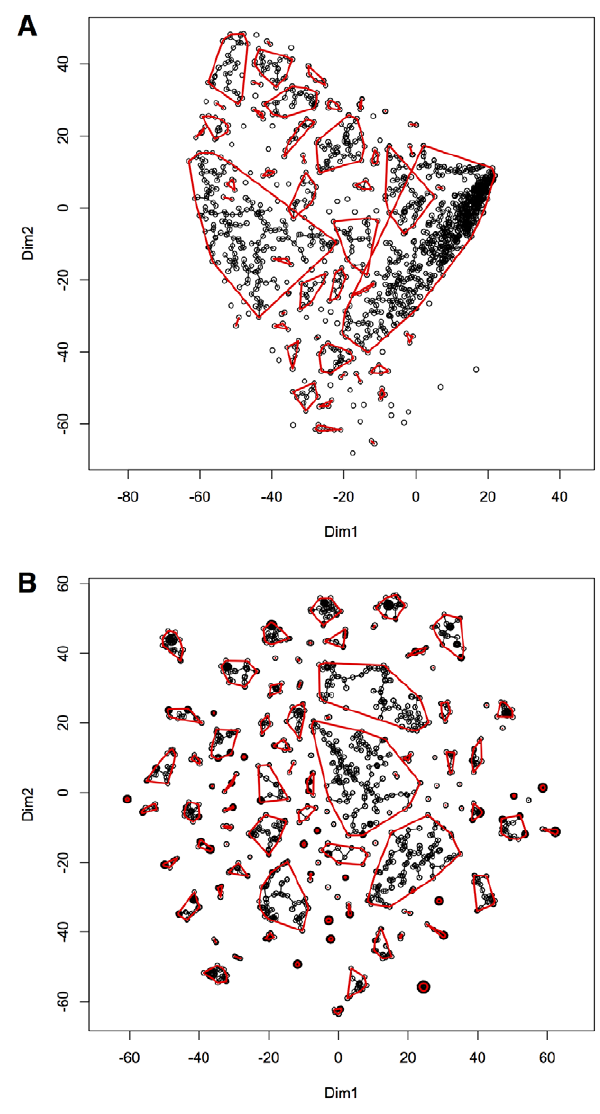
Figure 2. Spearman-Euclidean dissimilarity ( SED ) reduced to two dimensions by multidimensional scaling ( A ) or t-SNE ( B ) . 100 clusters were selected by single linkage minimum spanning trees. Red circles are drawn around the clusters.